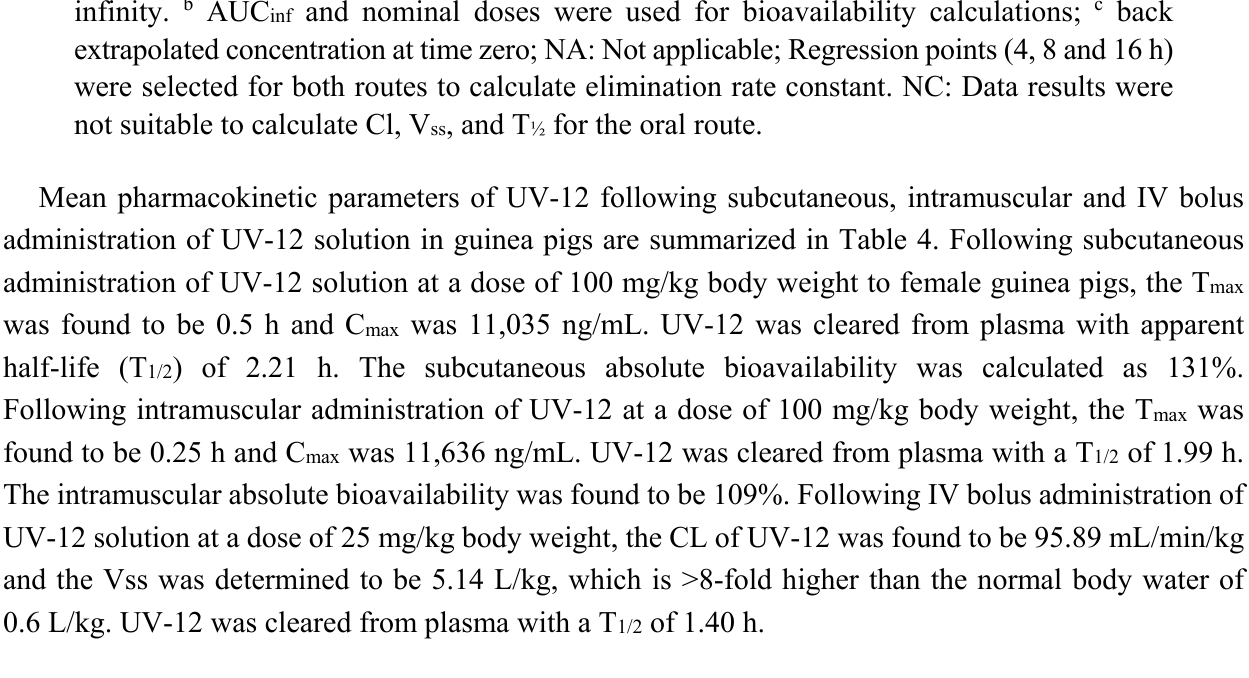
Table 4. Mean pharmacokinetic parameters of UV-12 in female Hartley guinea